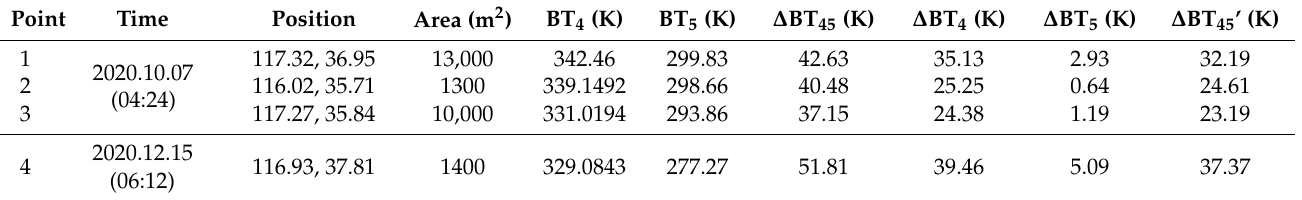
Table 4. Fires missing from the winter VIIRS fire products that were recovered by the improved algorithm. Point